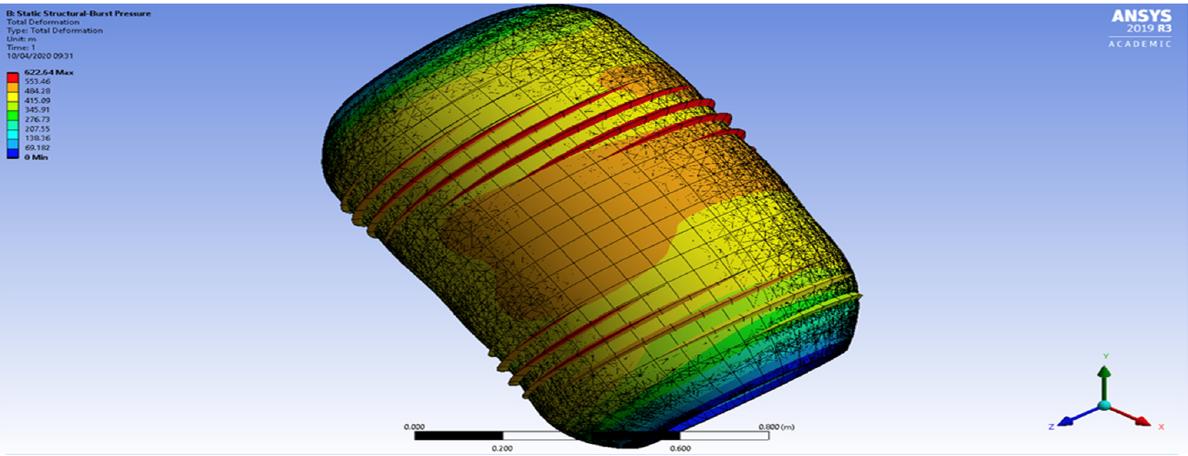
Figure 15. Liner wrinkling of different layers during extreme burst load for total deformation.